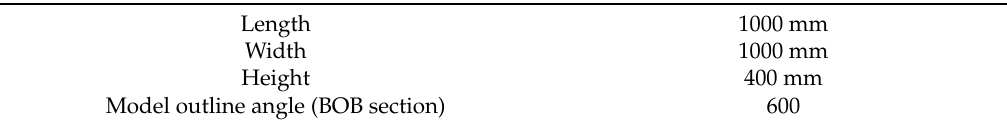
Table 2. Model geometry.